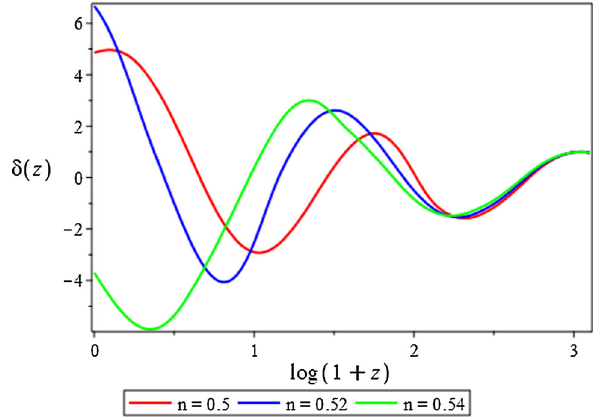
Fig. 14 δ( z ) versus z in long-wavelength mode for Eq. (115) for the values of 0 . 5 ≤ n ≤ 0 . 54